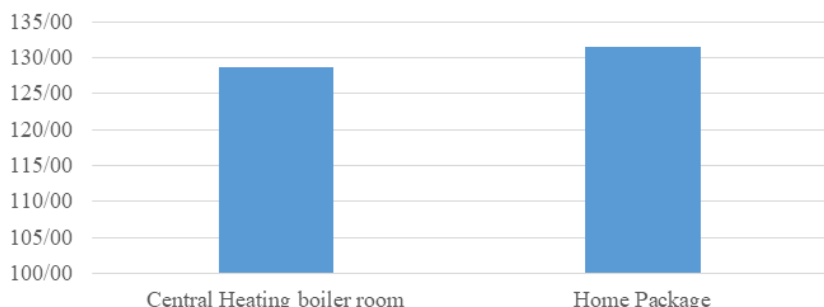
Figure 5. A comparison of the defuzzified mean RPN values for the two systems